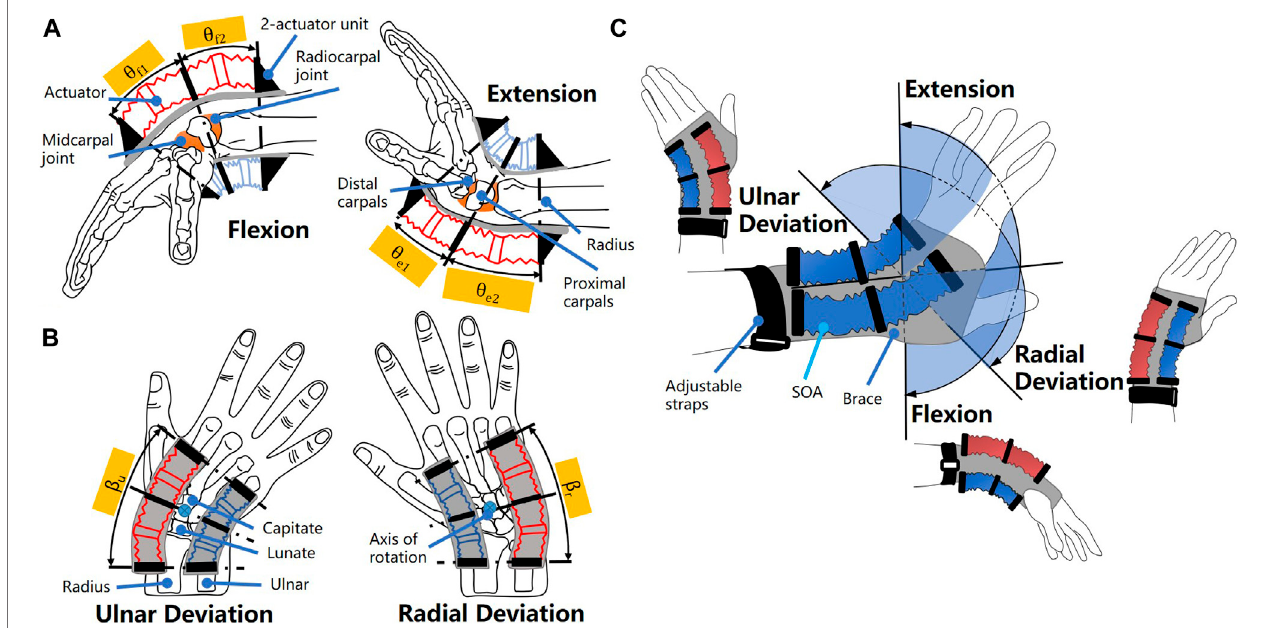
FIGURE1| ConceptoftheSRwristbrace.Theanatomyandarthrokinematicsofthewristin (A) fl exion/extensionandin (B) ulnar/radialdeviation; (C) thede fi nition of the 2-DoF wrist motions.